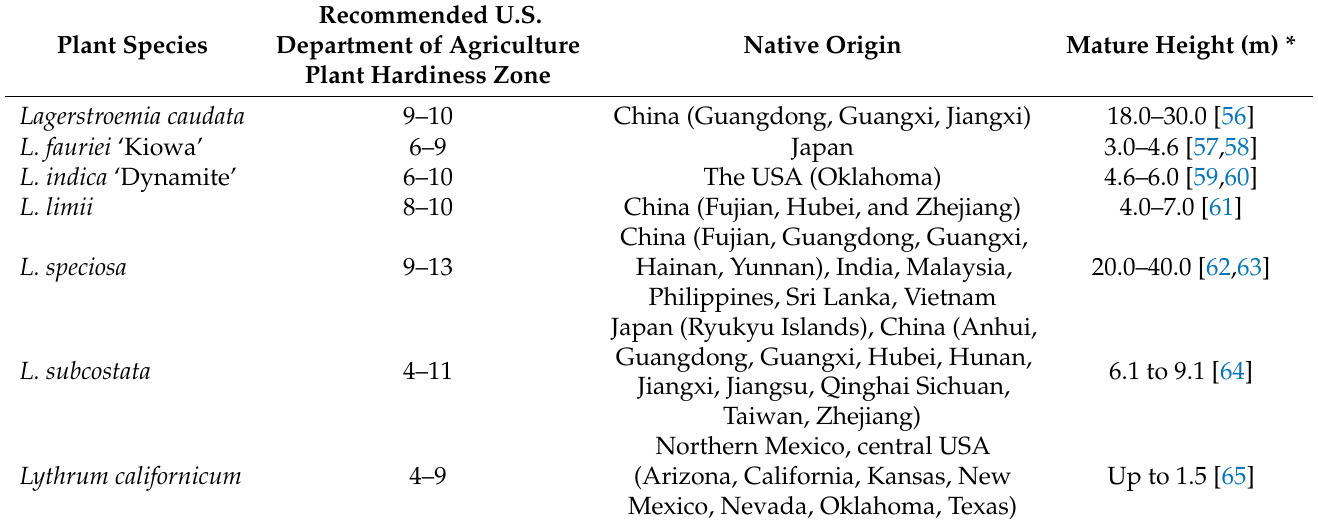
Table 1. Seven plant species evaluated as host candidates of crapemyrtle bark scale (CMBS). Recommended Plant Species